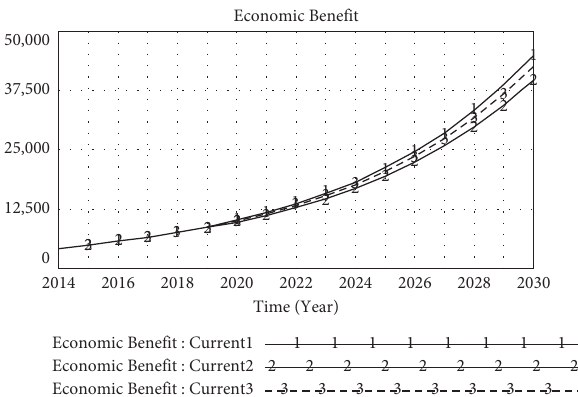
Figure 5: Trends in economic